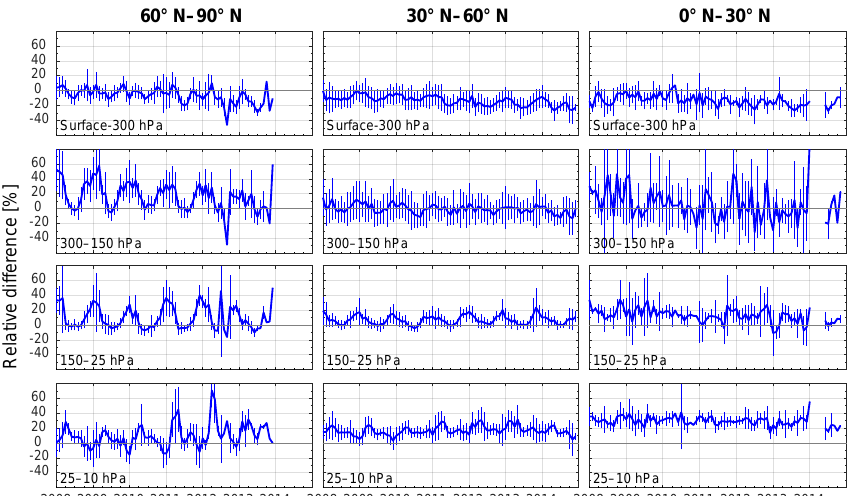
Figure 15. Monthly mean relative differences (in percent) between IASI-A and co-located smoothed ozonesonde for four different partial columns in the Northern Hemisphere: surface–300, 300–150, 150–25, and 25–10hPa, characterizing the troposphere (TROPO), the upper troposphere and the lower stratosphere (UTLS), the lower/middle stratosphere (LMS), and the middle stratosphere (MS) re- spectively. The error bars display the associated monthly mean standard deviation. The relative difference (in percent) is calculated as (100 × (IASI − SONDE) / SONDE).